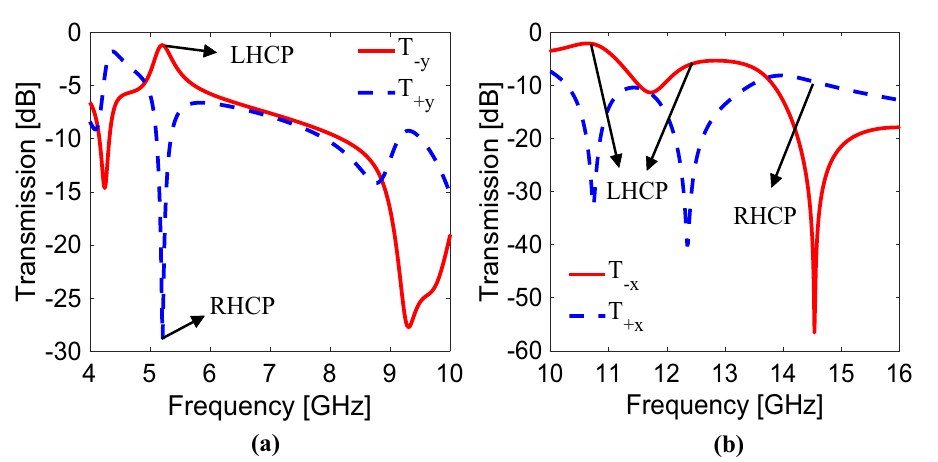
Figure 4. Circular polarization transmission components for ( a ) y-polarization, ( b )